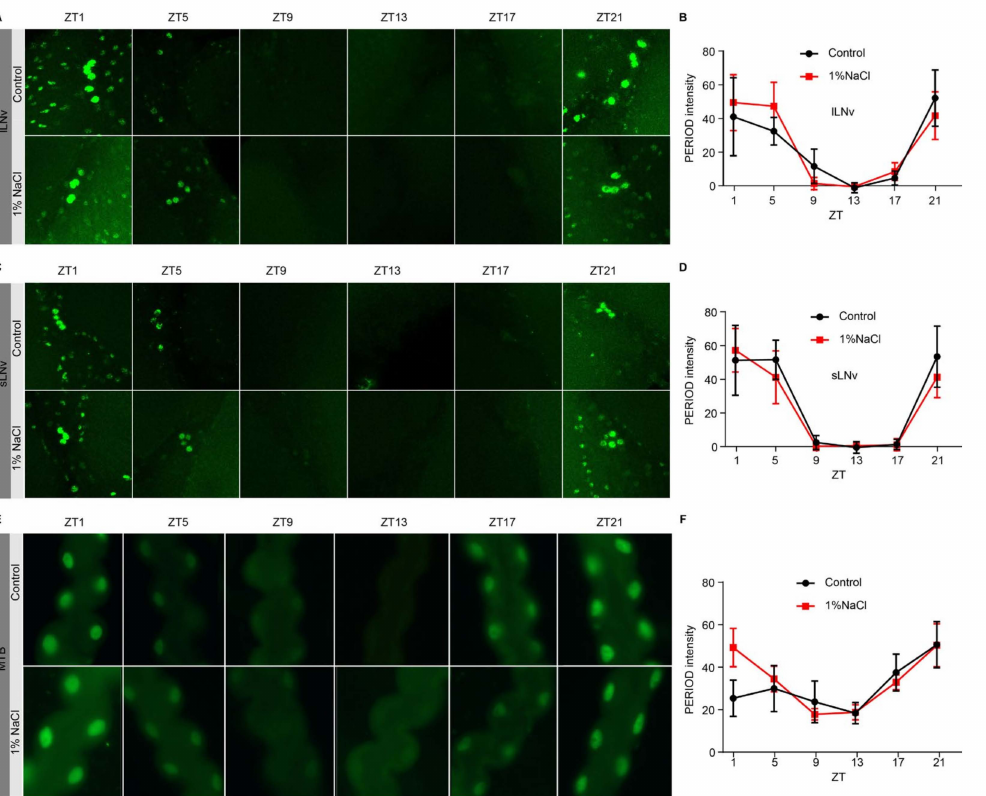
Figure 3. Oscillation of PER in period-EGFP flies with HSD and normal diet. ( A , B ) Oscillation of PER in the lLNvs. ( C , D ) Oscillation of PER in the sLNvs. ( E , F ). Oscillation of PER in the Malpighian